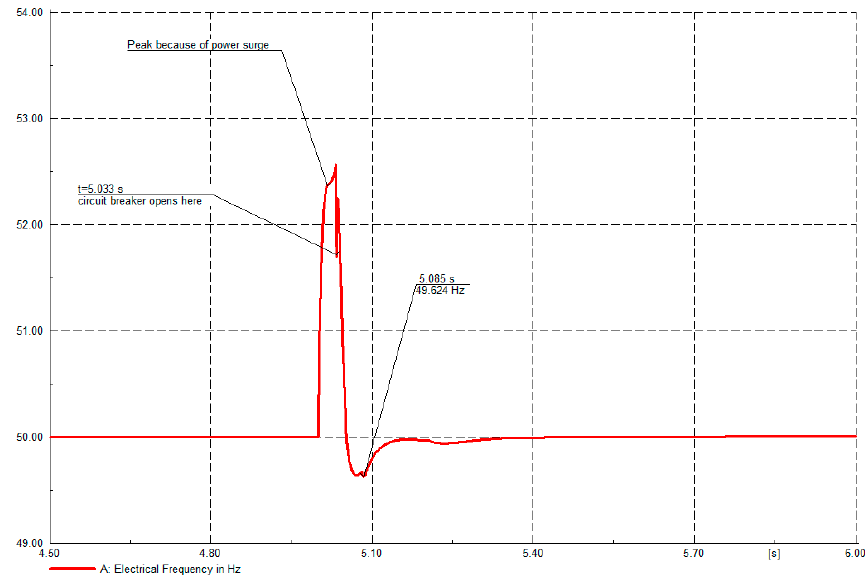
Figure 9. The frequency of the distribution network in case of the grid connected and islanded mode.